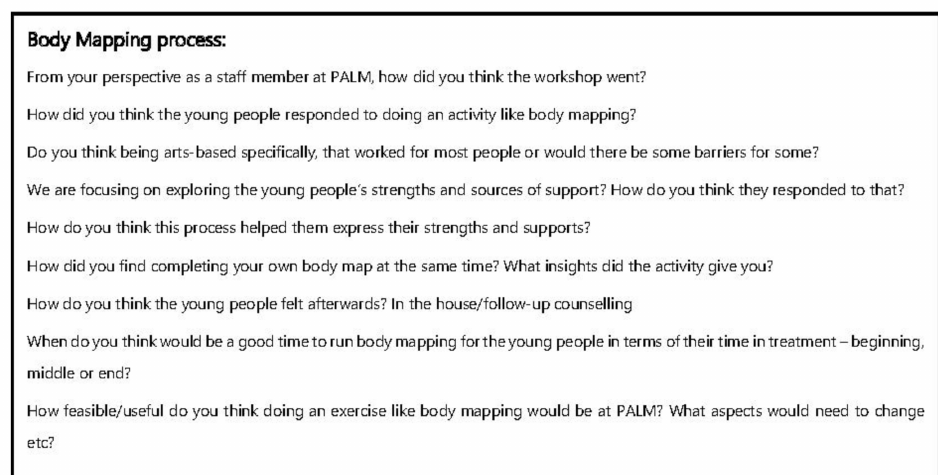
Figure 2. Interview Guide for PALM